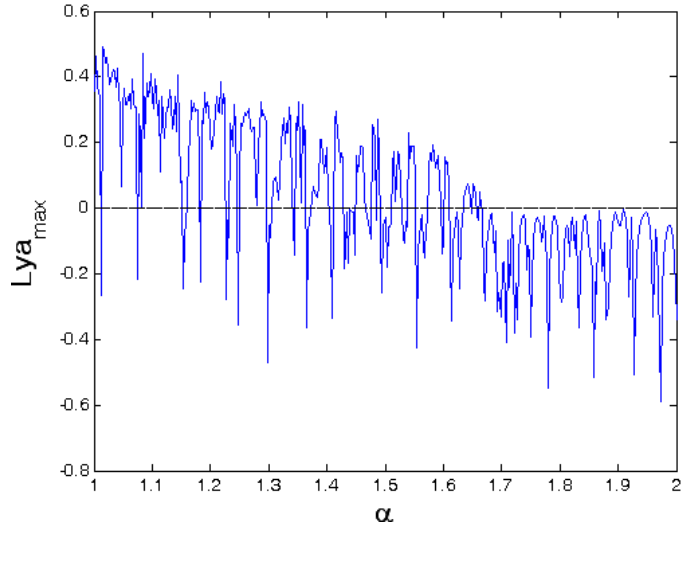
Figure 15. Largest Lyapunov exponent map of the equilibrium parameter α